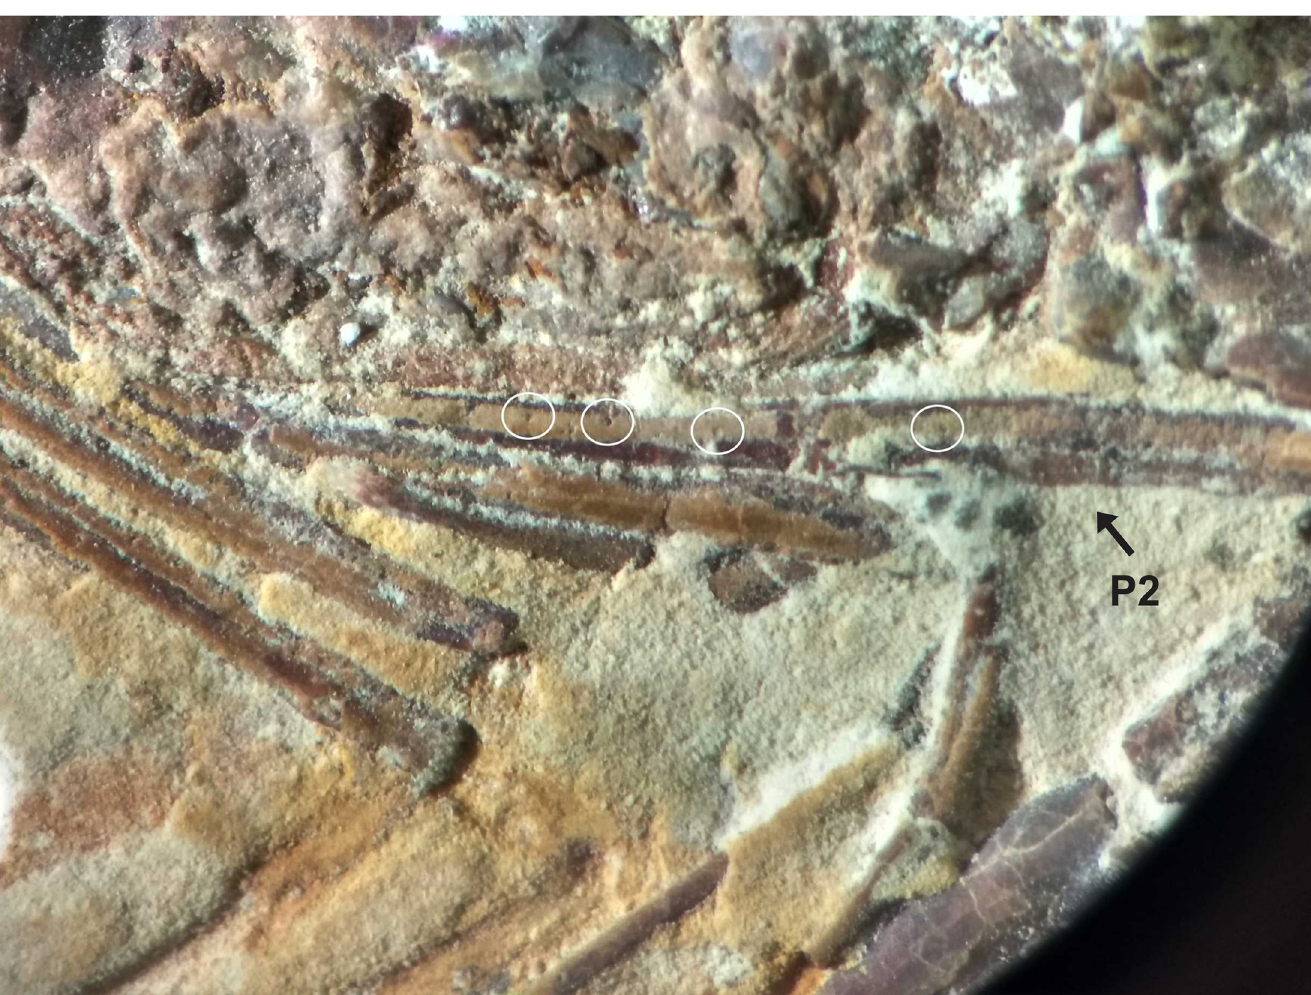
Fig 12. UFRJ 171/CR. Detail of the second pereiopods (P2) represented by chelipeds with several tubercles clearly in the merus and carpus. Photo by Olga A.